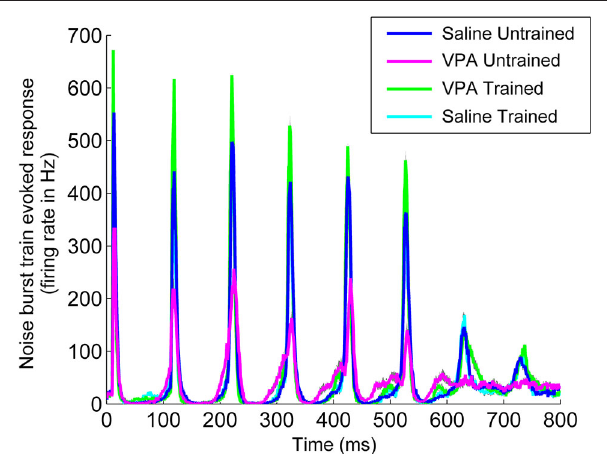
FIGURE 6 | Speech training enhances the neural response to a 10 Hz train of six noise bursts . The weak response to noise bursts in AAF in VPA untrained rats (magenta line) is enhanced in VPA speech trained rats (green line), and is compared to saline untrained rats (blue line) and saline speech trained rats (cyan line). Gray shading indicates s.e.m. across recording sites.